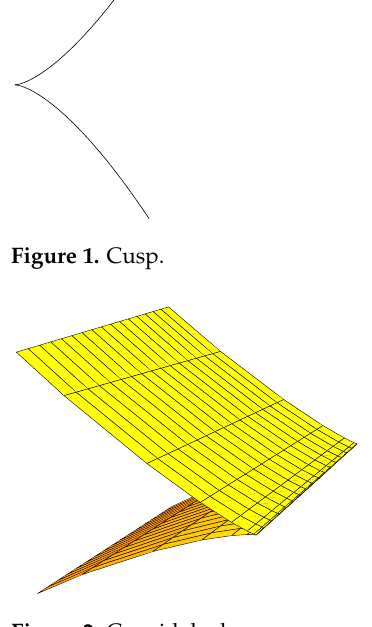
Figure 2. Cuspidal edge.